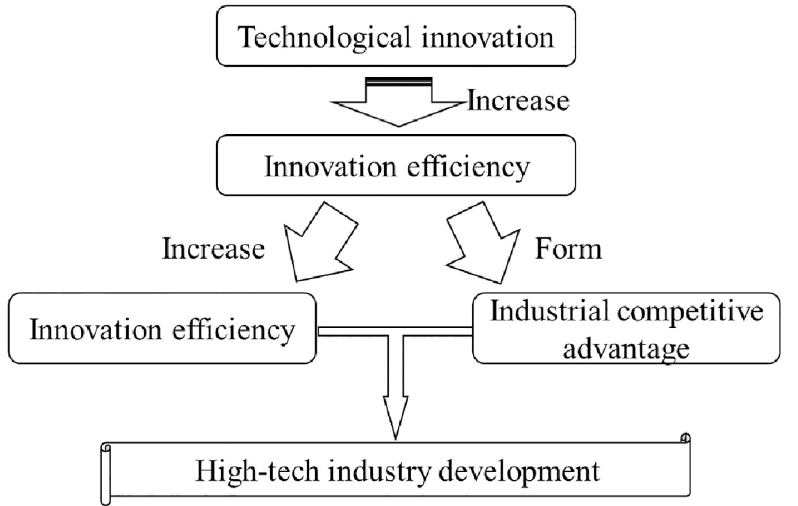
Fig 1. Positive evolution path of technological innovation in high-tech industries.